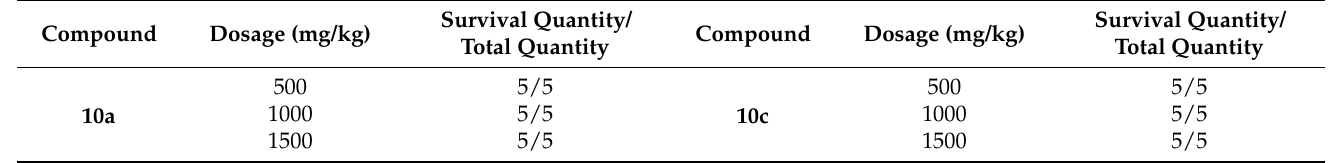
Table 9. Acute toxicity of the investigated compounds.